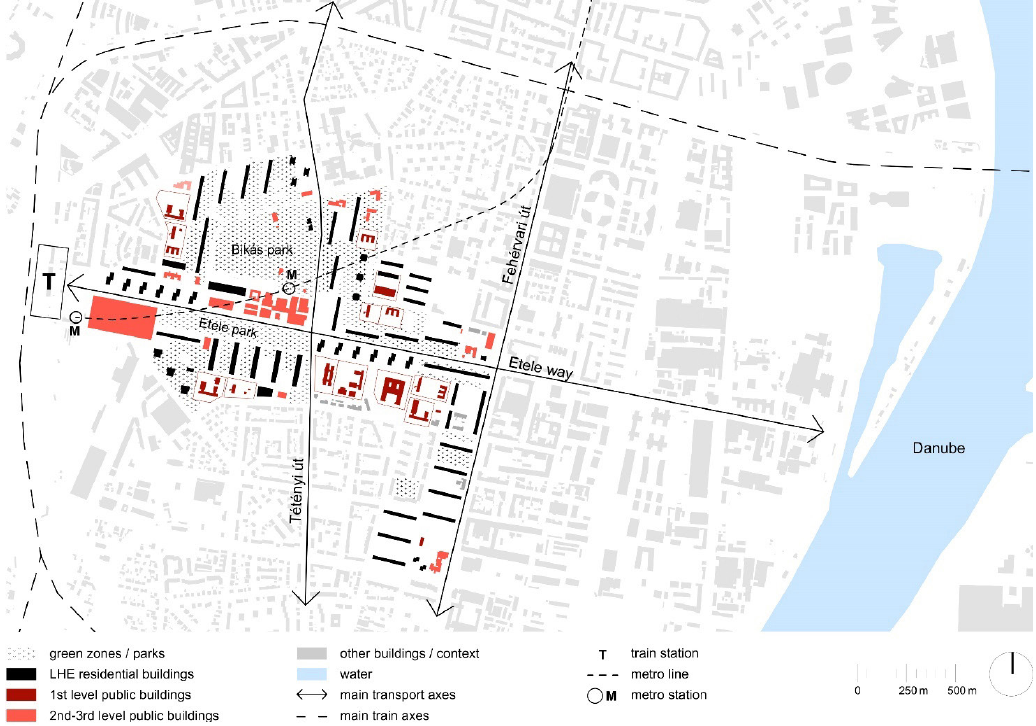
Figure 3. Kelenföld LHE actual structure and functional composition, 2022 (source: author)